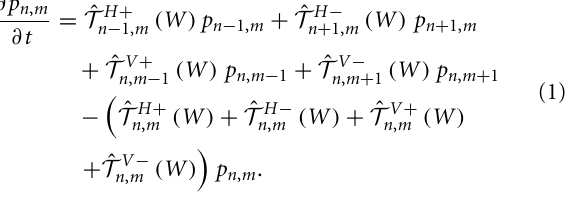
FIGURE 1 | (A) Geometry of the model domain. A source ofVEGF (e.g., a tumor) is situated at x = 1.VEGF diffuses toward a parent vessel located at x = 0, and is taken up by endothelial cells lining it.The activated cells migrate up gradients ofVEGF, elongating behind them capillaries. (B–D) Motion of a cell on a 2-d lattice in response toVEGF stimulus.The cell